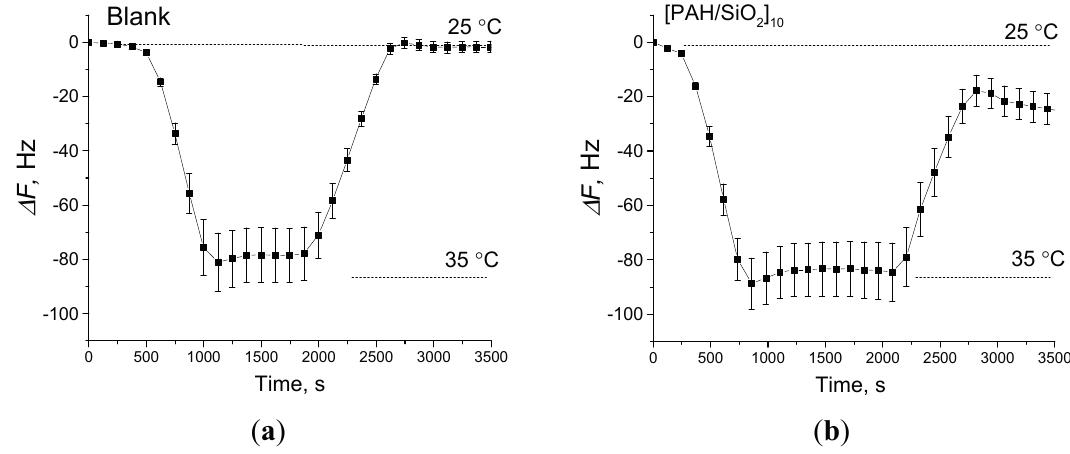
Figure 4. Response of the different QCM electrodes to the temperature change from 25 °C to 35 °C and back. Averaged frequency response for ( a ) 5 unmodified QCM electrodes; and ( b ) 5 QCM electrodes modified with a coating of [PAH/SiO 2 ] 10 ,